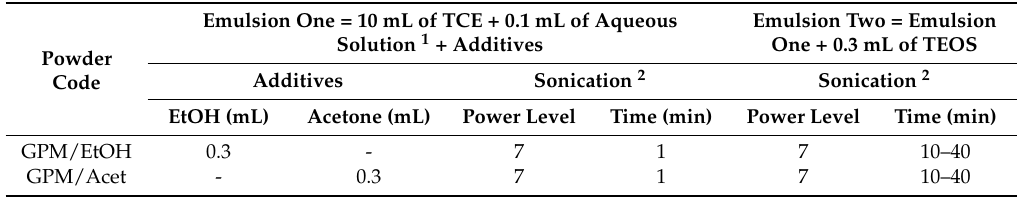
Table 1. Preparation of the water/oil (W/O) emulsions for the synthesis of silica powder. Acet: acetone, EtOH: ethanol, GPM: gravimetric powder method, TCE: trichloroethylene, TEOS: